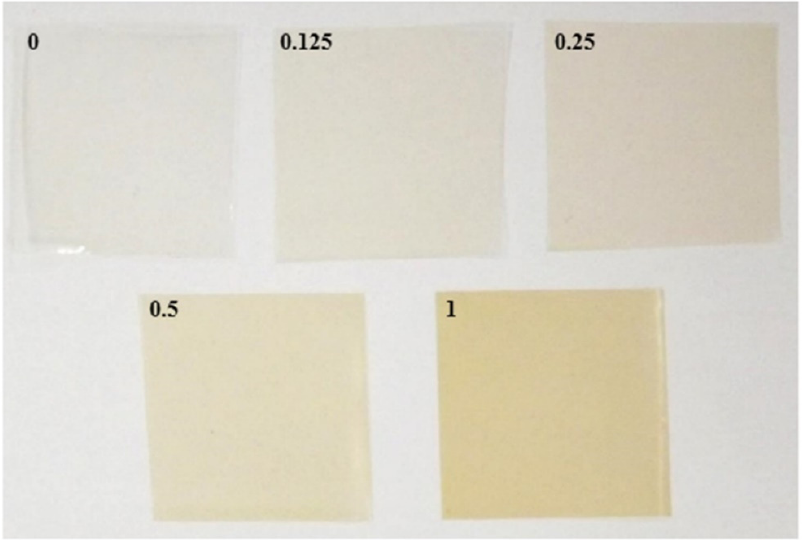
Figure 1. Film appearance of rice-starch-pectin films incorporated with green tea extract at different concentrations. The numbers designate concentrations of green tea extract (% w/v ). Table 1. The color values of rice-starch-pectin films incorporated with green tea extract at different